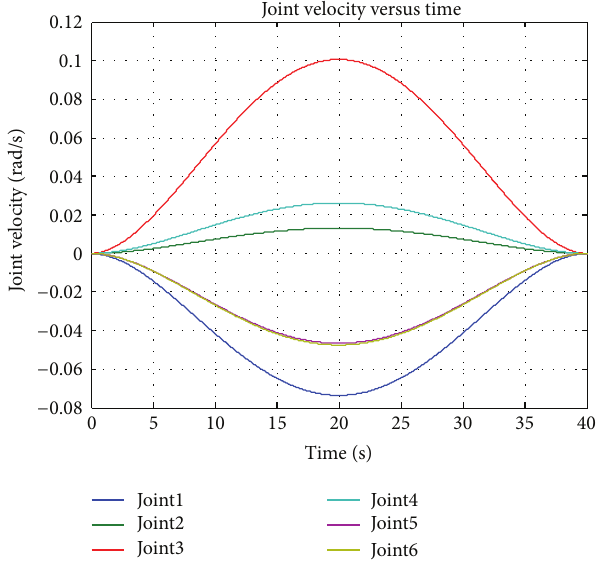
Figure 10: Joint velocity evolution during the dynamic